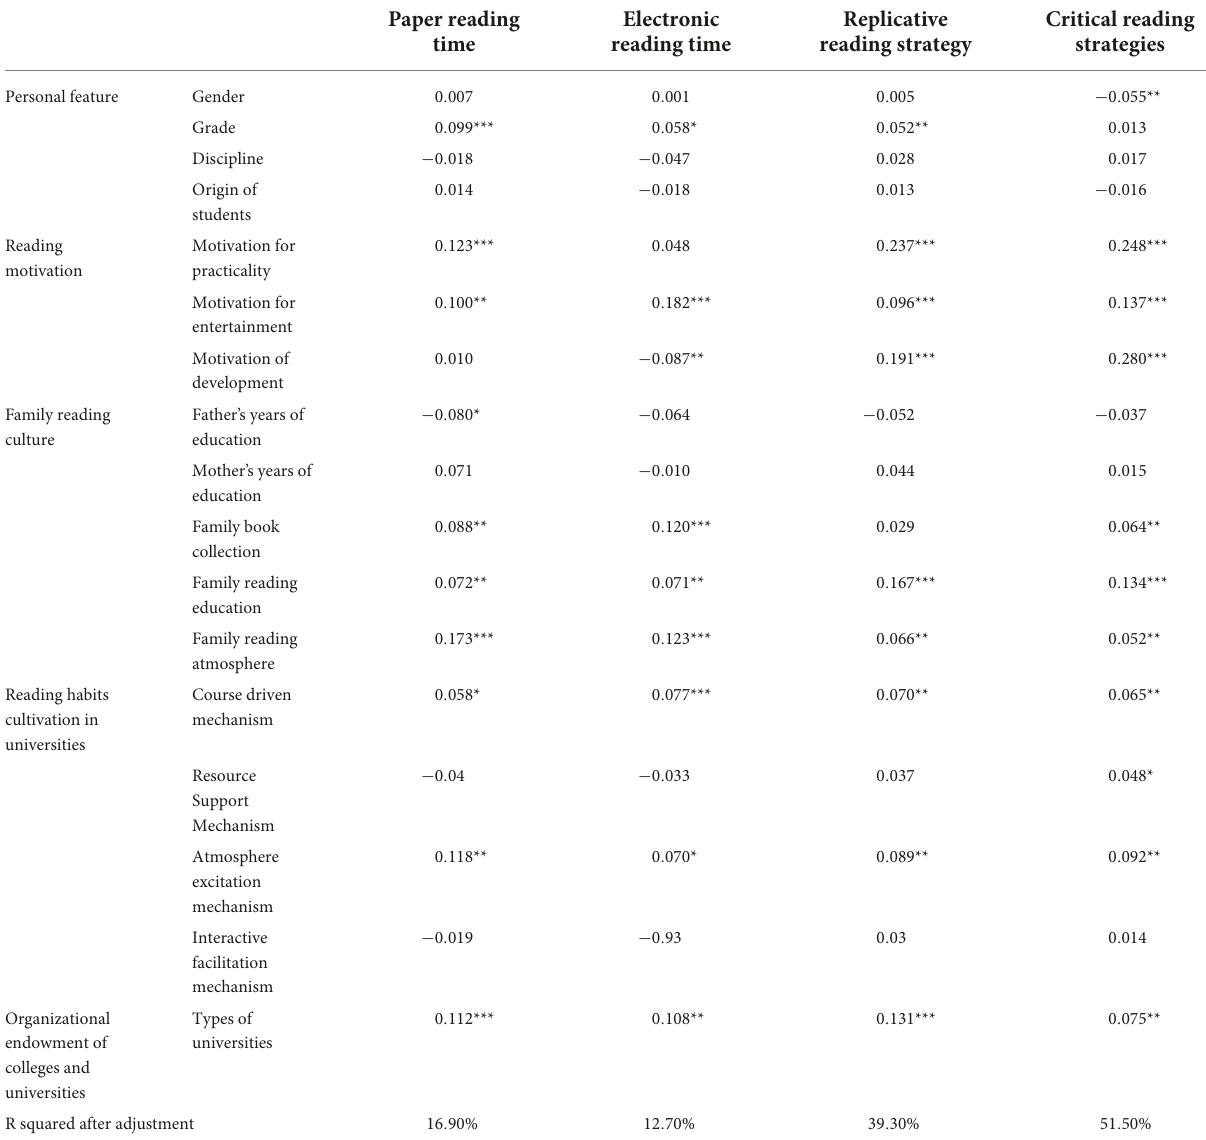
TABLE 5 Results of multiple linear regression of college students’ reading